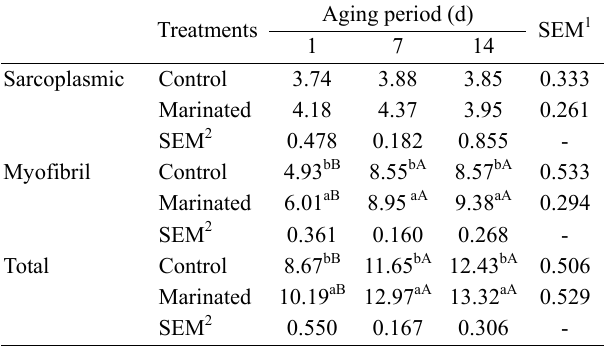
Table 6. Effect of aging and marination on protein solubility of